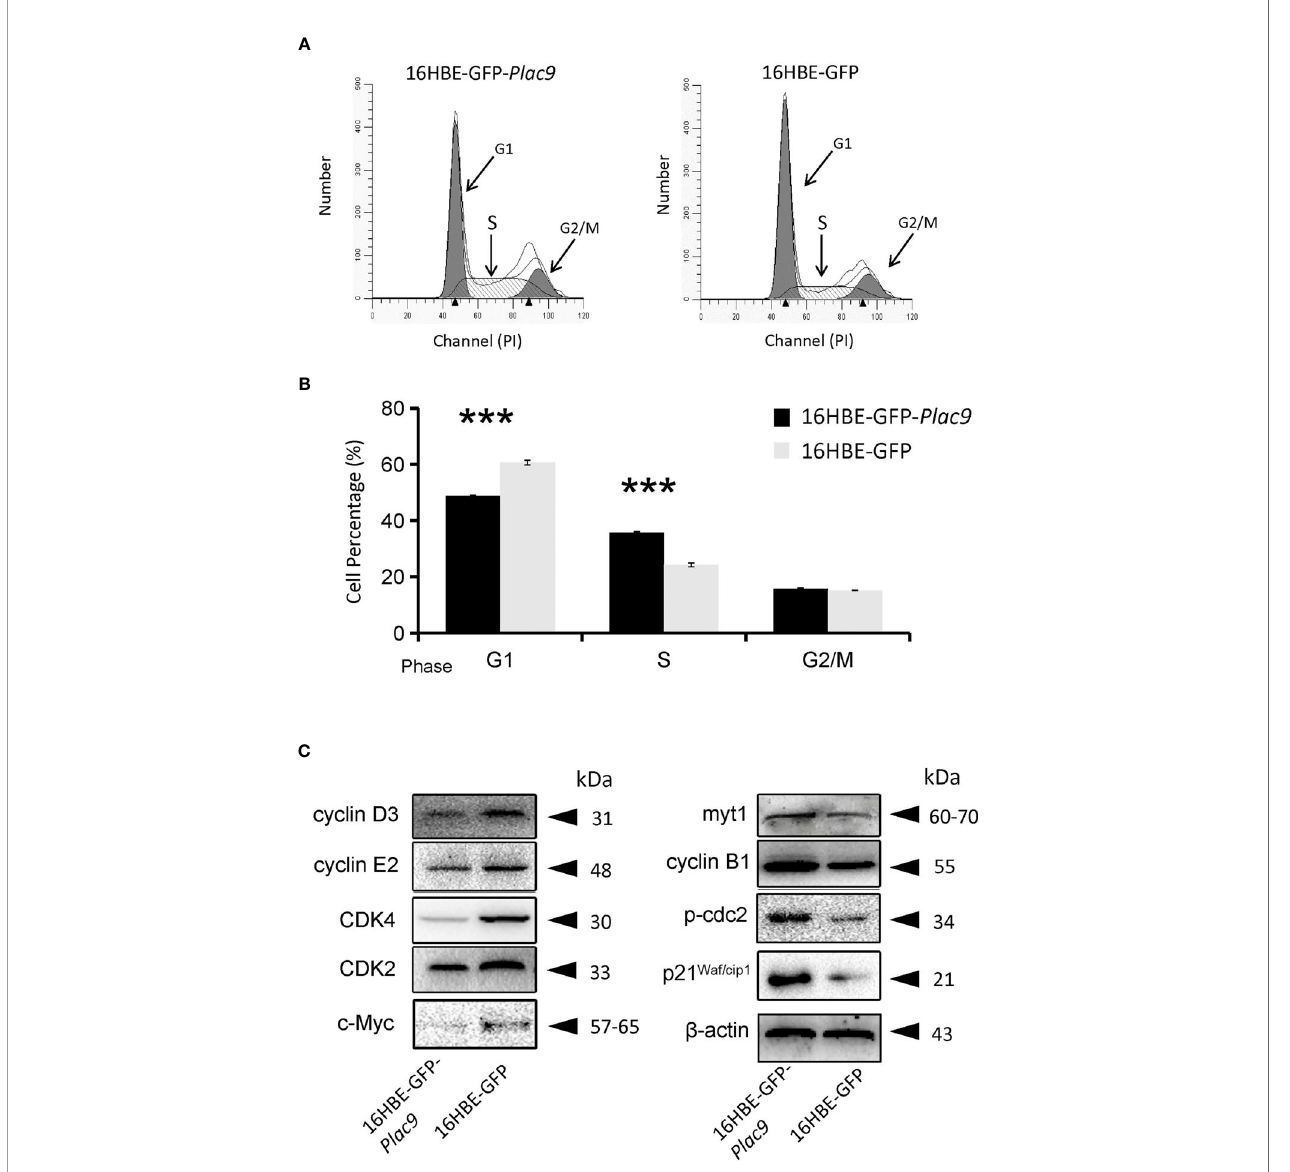
FIGURE 7 | Overexpression of PLAC9 alters cell cycle distribution. (A, B) Overexpression of PLAC9 increases the cell population in S phase, while reducing the number of cells in G1 phase. 16HBE-GFP- Plac9 and control 16HBE-GFP cells were incubated with PI and analyzed using fl ow cytometry (A) and quanti fi ed (B) . (*** p < 000.1). (C) Plac9 overexpression alters the expression of cell cycle proteins The total proteins of 16HBE-GFP- Plac9 and the control line 16HBE-GFP were isolated for western blot analysis of cell cycle-related proteins. Representative blots from three experiments with similar results are